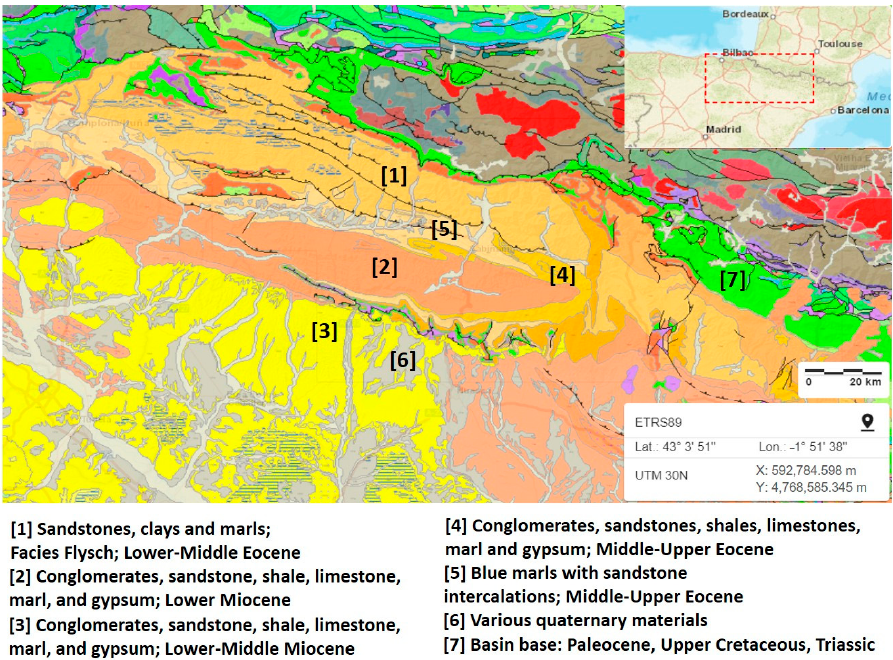
Figure 2. Geological map of the Jaca Basin (modified from the “Instituto Geológico y Minero de España”, cartographic viewer).